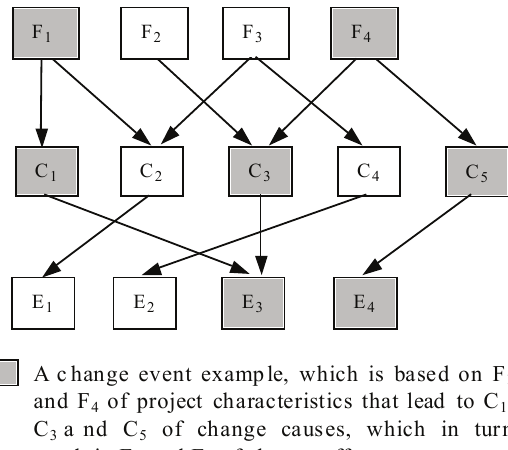
Figure 3: A relationship diagram for a change